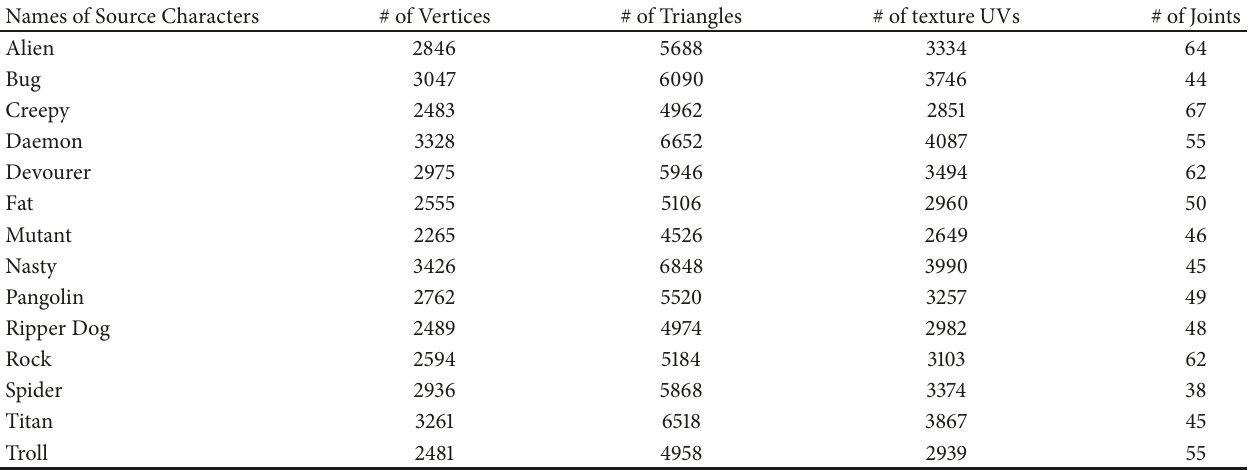
Table 1: The data information of the source charactersused in our experiment. Note that the data information represents the characters that are prior to the process of UV-guided mesh rebuilding (see Section